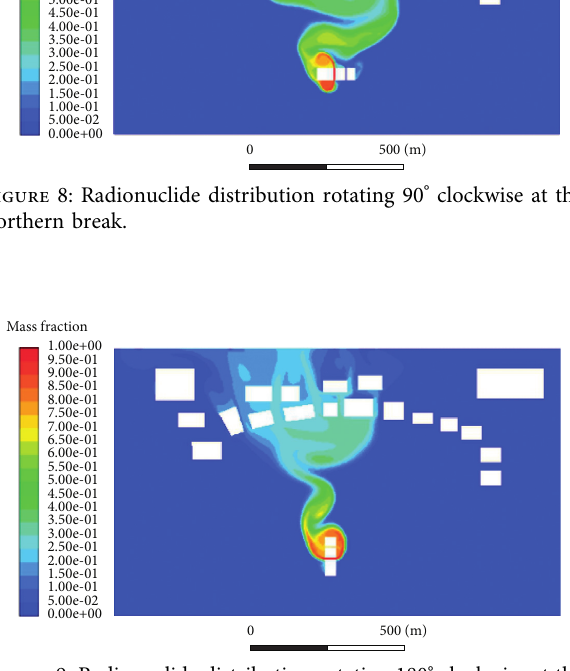
Figure 9: Radionuclide distribution rotating 180 ° clockwise at the northern break.